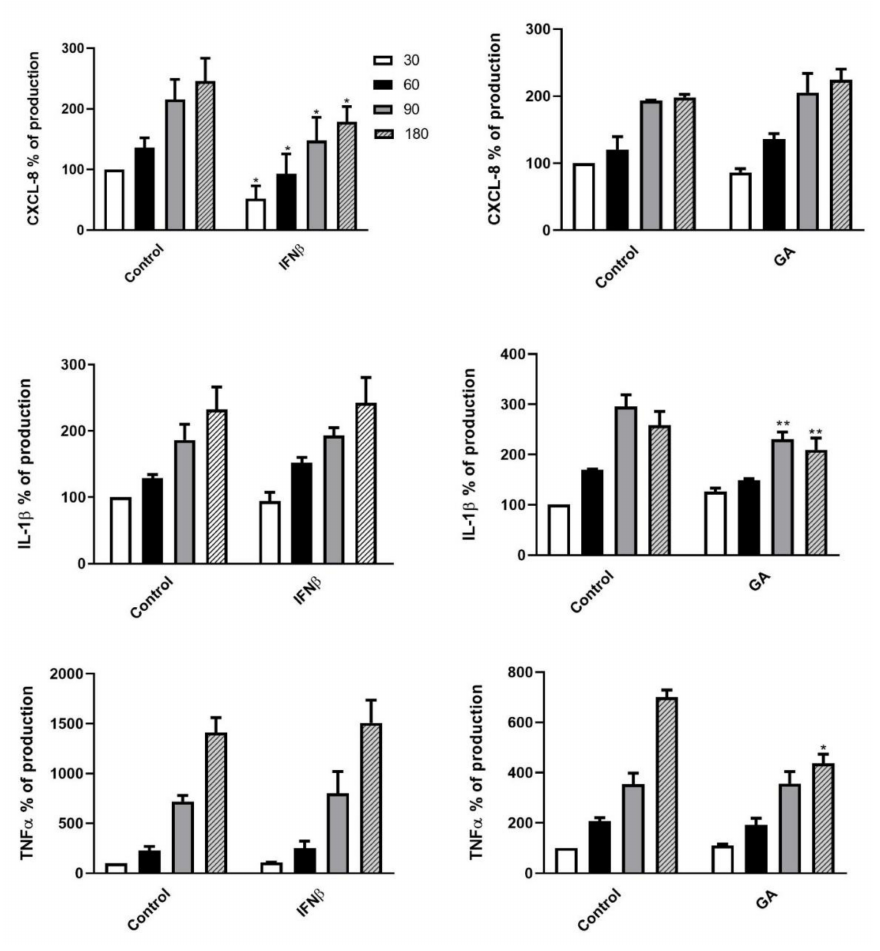
Figure 5. First-line DMTs reduced cytokine release by PMNs stimulated with K. pneumoniae. Supernatants of pretreated PMNs with IFN β -1b (left panel) or GA (right panel), incubated in the presence of K. pneumoniae (ratio 10:1) for 30, 60, 90 and 180 min, were assayed to evaluate CXCL8, IL-1 β and TNF- α production. Data are shown as mean ± SEM from at least three independent experiments. * p < 0.01 or ** p < 0.05 vs. untreated cells following K. pneumoniae challenge, by using the unpaired T-test. Results from untreated cells following K. pneumoniae stimulation at T30 are set as 100%.